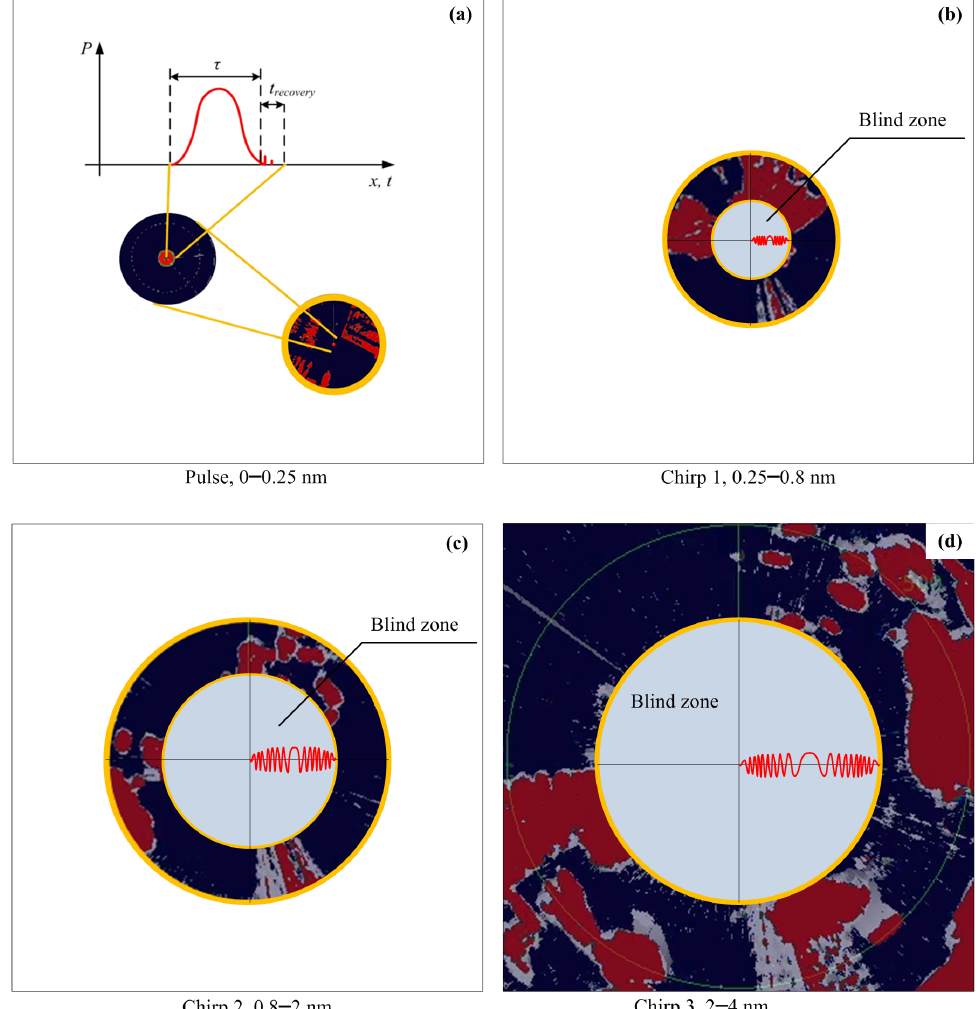
Figure 2. Radar signal stitching: ( a ) Pulse, 0–0.25 nm and explanation of “main bang“. ( b ) Chirp 1, 0.25–0.8 nm. ( c ) Chirp 2, 0.8–2 nm. ( d ) Chirp 3, 2–4